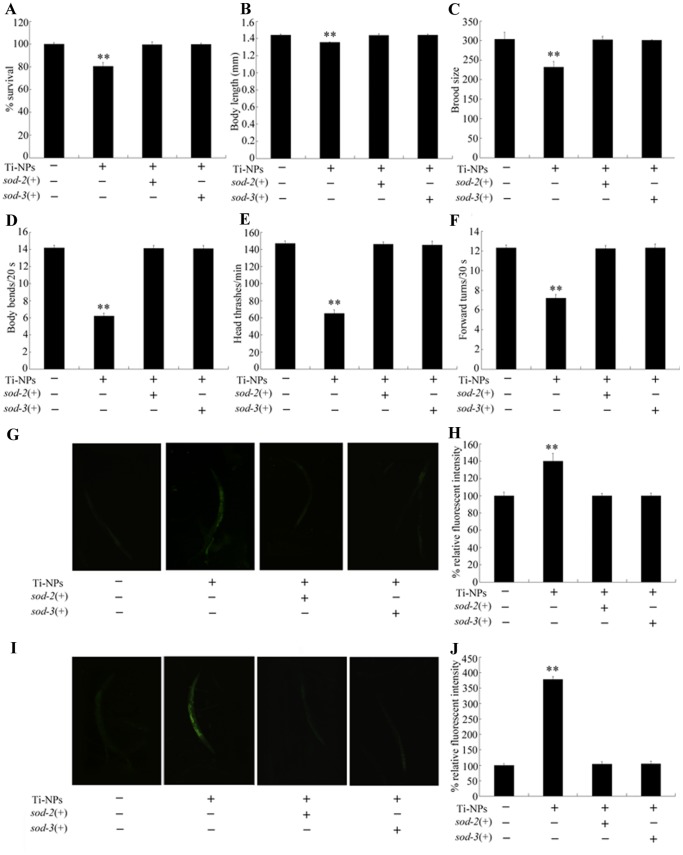
Effects of ectopically expression of nematode sod-2 or sod-3 gene on the toxicity formation in animals exposed to 4 nm TiO2-NPs at the concentration of 10 µg/L.(A) Effects of ectopically expression of sod-2 or sod-3 gene on the survival of nematodes exposed to 4 nm TiO2-NPs at the concentration of 10 µg/L. (B) Effects of ectopically expression of sod-2 or sod-3 gene on the growth of nematodes exposed to 4 nm TiO2-NPs at the concentration of 10 µg/L. (C) Effects of ectopically expression of sod-2 or sod-3 gene on the reproduction of nematodes exposed to 4 nm TiO2-NPs at the concentration of 10 µg/L. (D–F) Effects of ectopically expression of sod-2 or sod-3 gene on the locomotion behavior of nematodes exposed to 4 nm TiO2-NPs at the concentration of 10 µg/L. (G–H) Effects of ectopically expression of sod-2 or sod-3 gene on the intestinal autofluorescences of nematodes exposed to 4 nm TiO2-NPs at the concentration of 10 µg/L. (I–J) Effects of ectopically expression of sod-2 or sod-3 gene on the ROS production of nematodes exposed to 4 nm TiO2-NPs at the concentration of 10 µg/L. sod-2(+), Ex(Psod-2-sod-2); sod-3(+), Ex(Psod-3-sod-3). Exposure of TiO2-NPs was performed from L1-larvae, and the endpoints were examined when nematodes developed into the adults. Ti-NPs, TiO2-NPs. The Bars represent mean±S.E.M. **p<0.01.